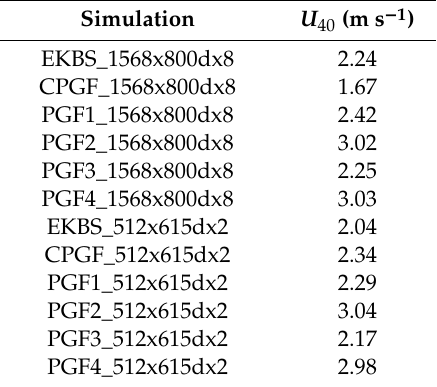
Table 5. Mean wind velocity at z ref = 40 m. The target wind speed is 3 m s − 1 .